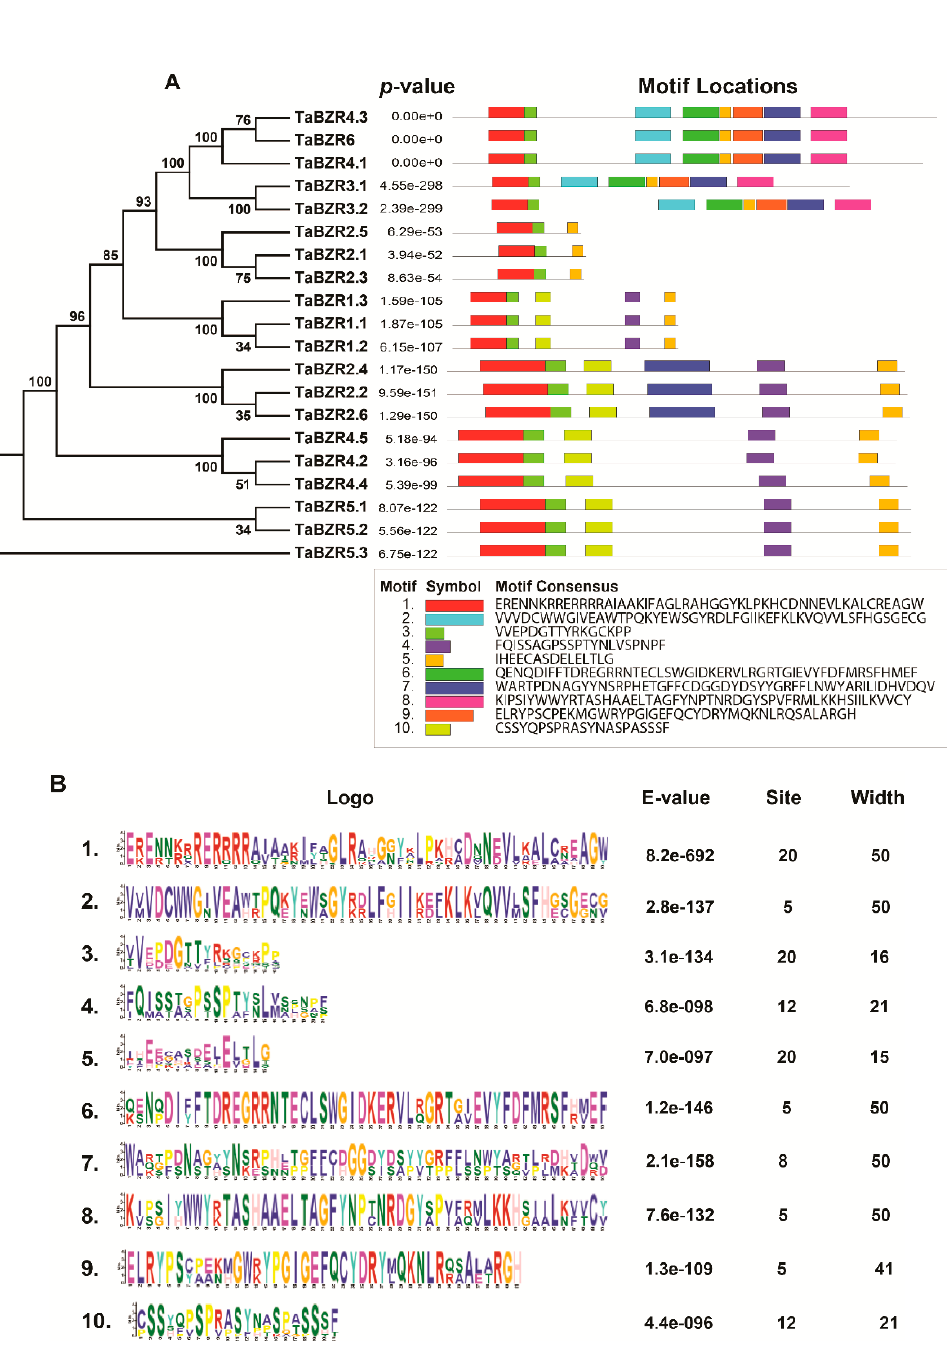
indicated by blue boxes, and black lines represent introns. The lengths of the boxes and lines are scaled based on gene